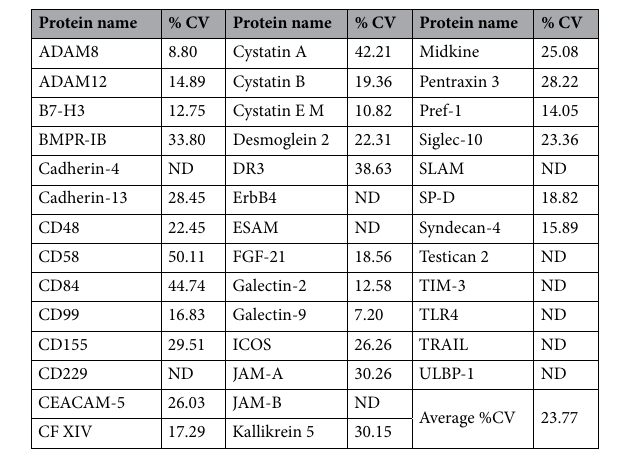
Table 1. Intra-assay variability. Average within-subject % CV from 10 independent DBS strips. Eluate from each strip was run on a multi-plex array capable of measuring 40 proteins. 29 out of the 40 proteins were measurable, and the % CV is presented for each protein. The overall average % CV across all 29 proteins was also presented. ND: not